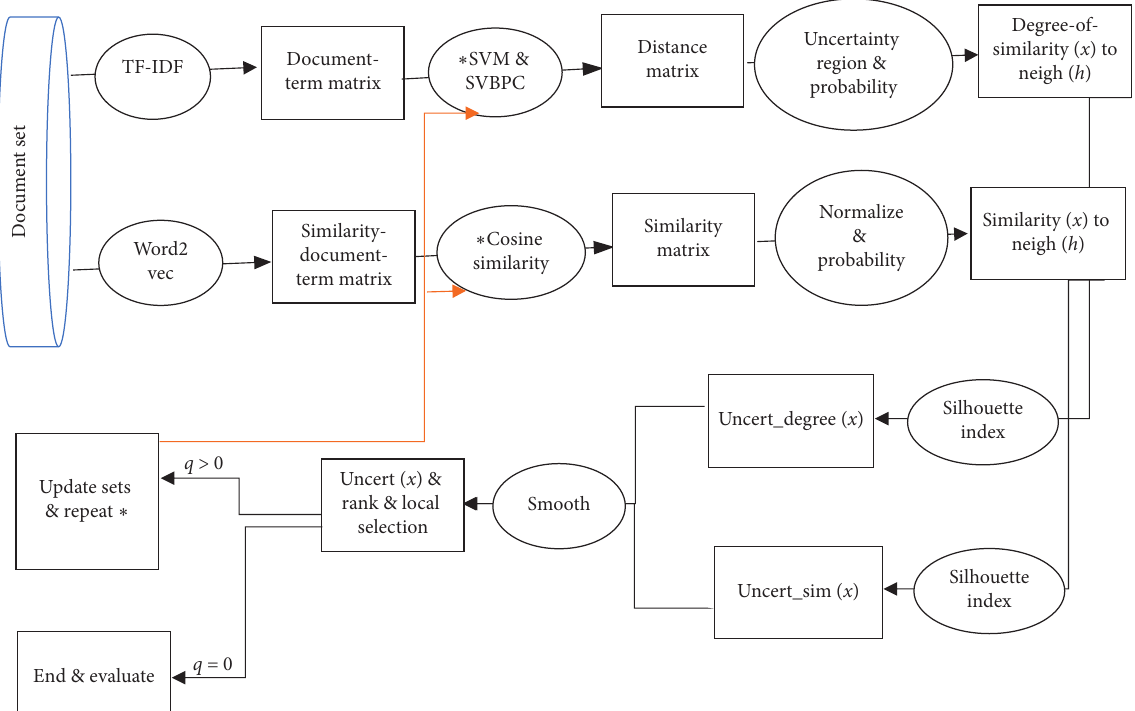
Figure 1: The overview of the proposed